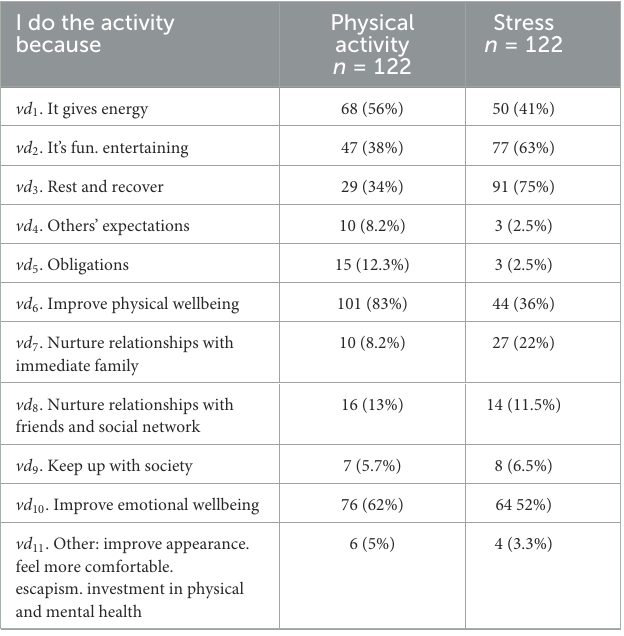
TABLE 4 Motivations in terms of value directions ( vd ) for the participant’s chosen baby-step activity to increase physical activity or decrease